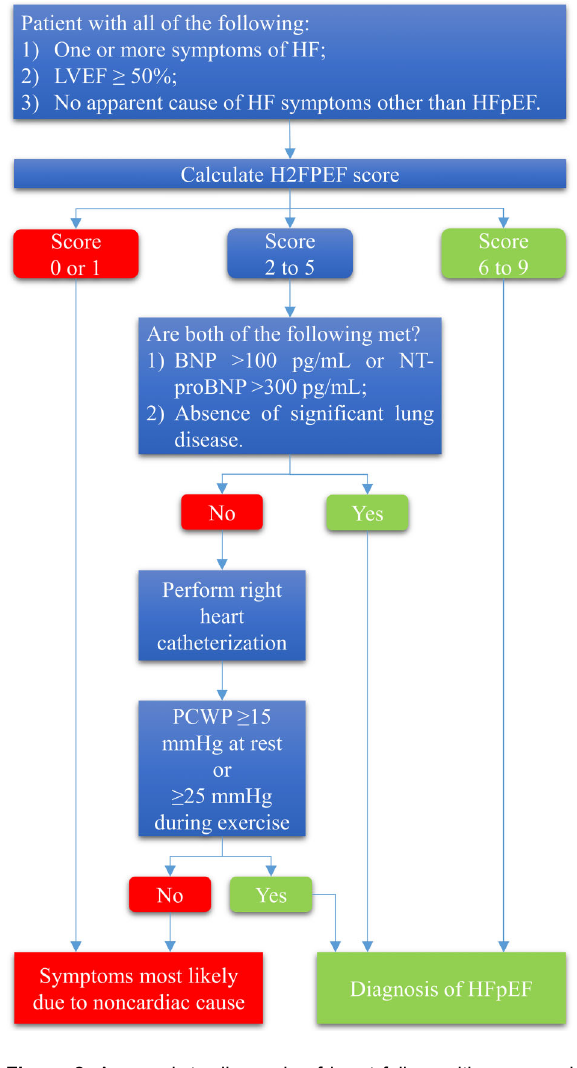
Figure 2. Approach to diagnosis of heart failure with preserved ejection fraction (HFpEF). LVEF: left ventricular ejection